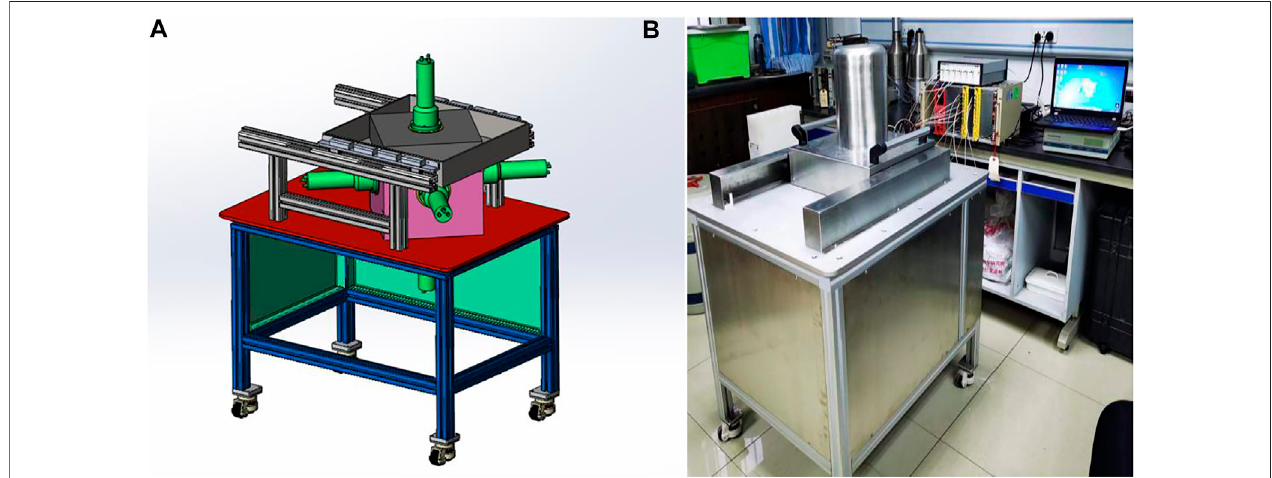
FIGURE 1 | Model of the detection system: (A) Theoretical model diagram (B) Actual model diagram.